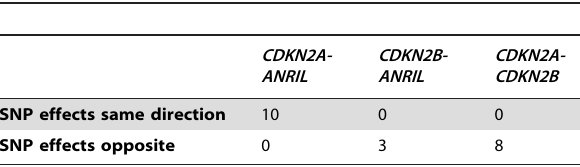
Table 2. Correlation of SNP effects between genes by aeQTL